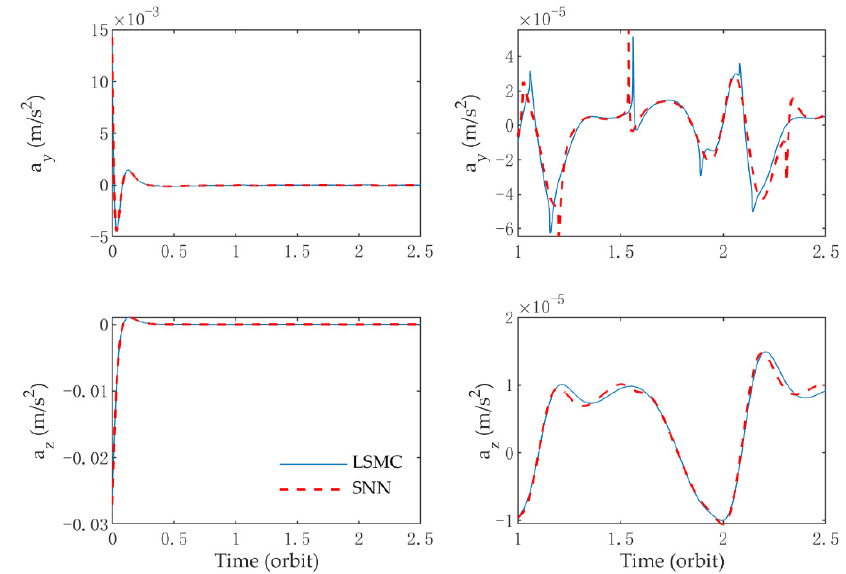
Figure 4. Time histories of control inputs for the case without radial control.